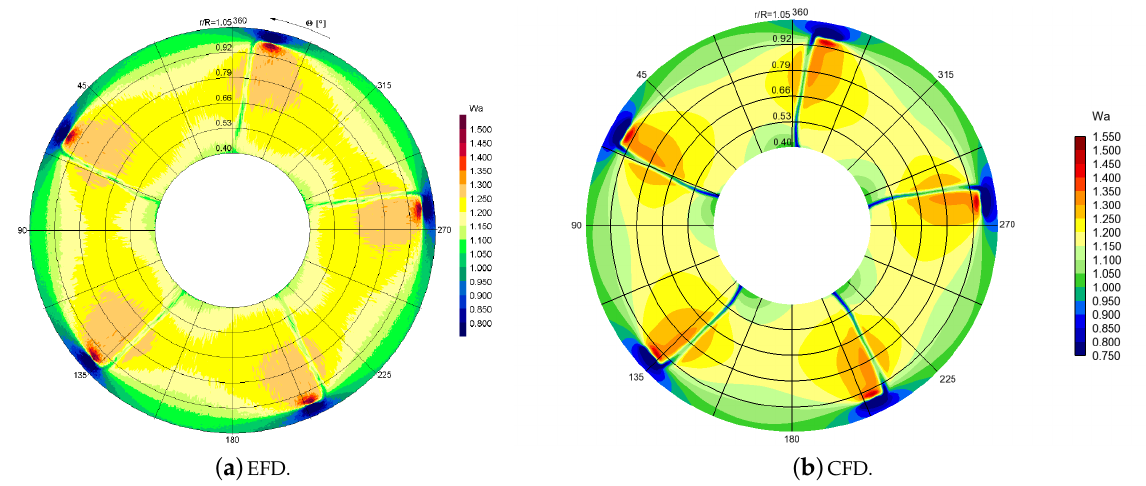
Figure 9. Comparison of axial wake distributions at x / D = 0.13 behind the propeller.